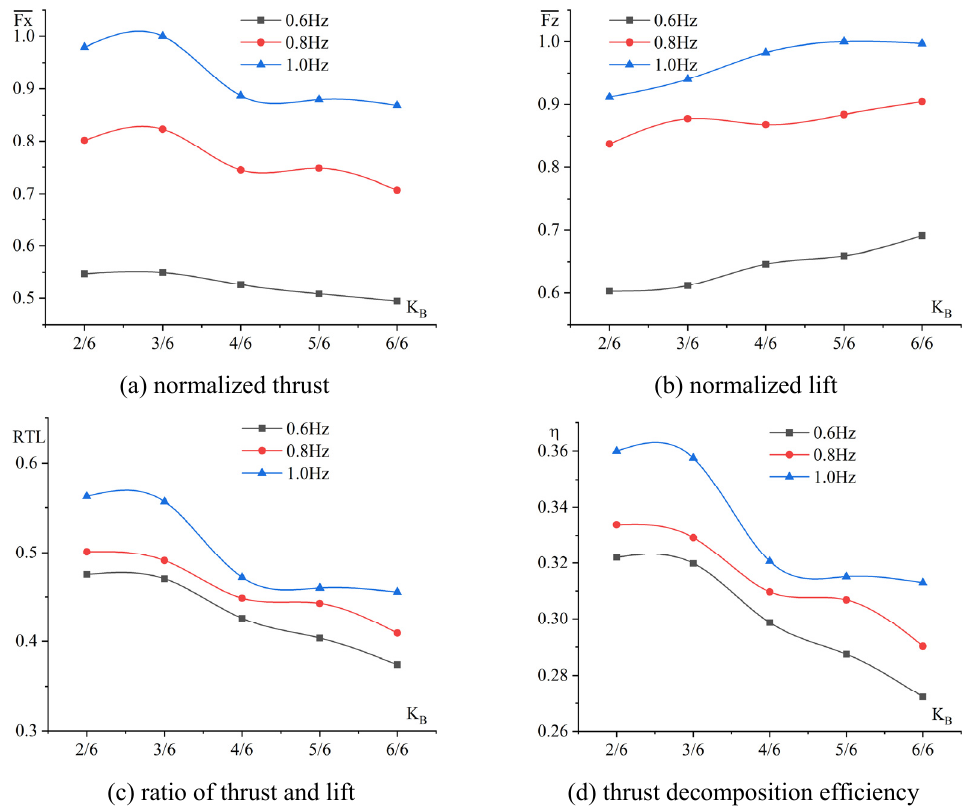
Figure 7. Results of rear edge.